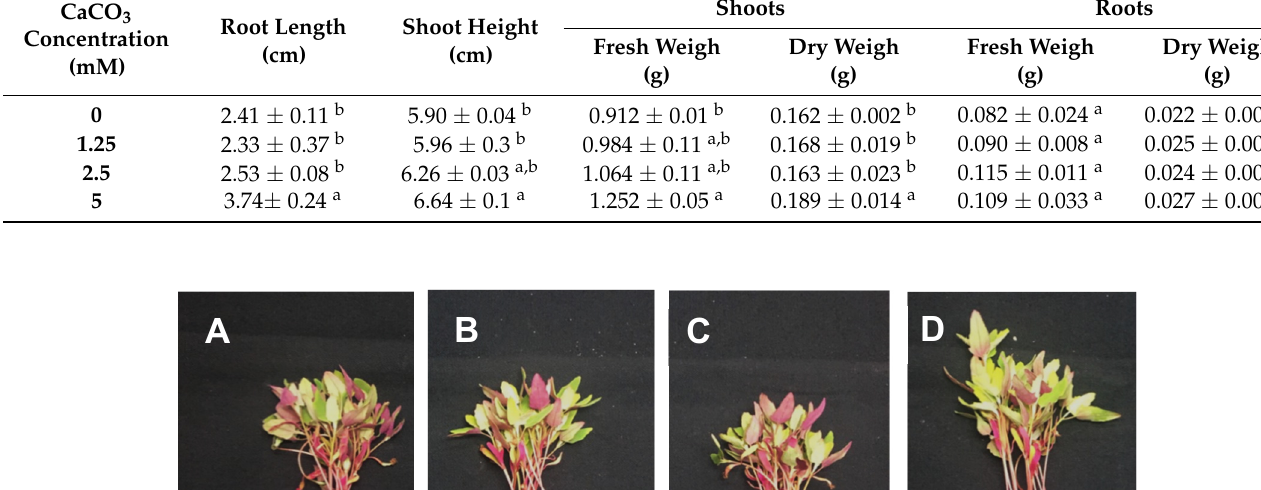
Table 1. The effect of calcium carbonate on the growth traits of Djulis sprouts. The 7-d-old djulis plants were treated with 0 mM, 1.25 mM, 2.5 Mm and 5 mM CaCO 3 for 7 days, the growth characteristics of seedlings were investigated. Data are means ± SE ( n = 10), repeated three times. Values with the same letter are not significantly different at p < 0.05. CaCO 3 Concentration